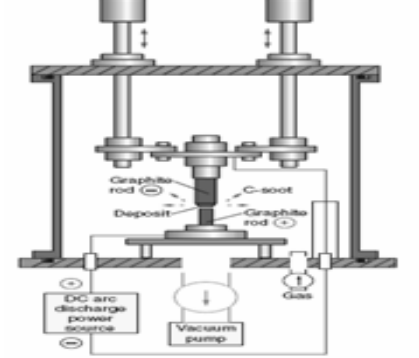
Figure 1 . Schematic diagram of arc discharge